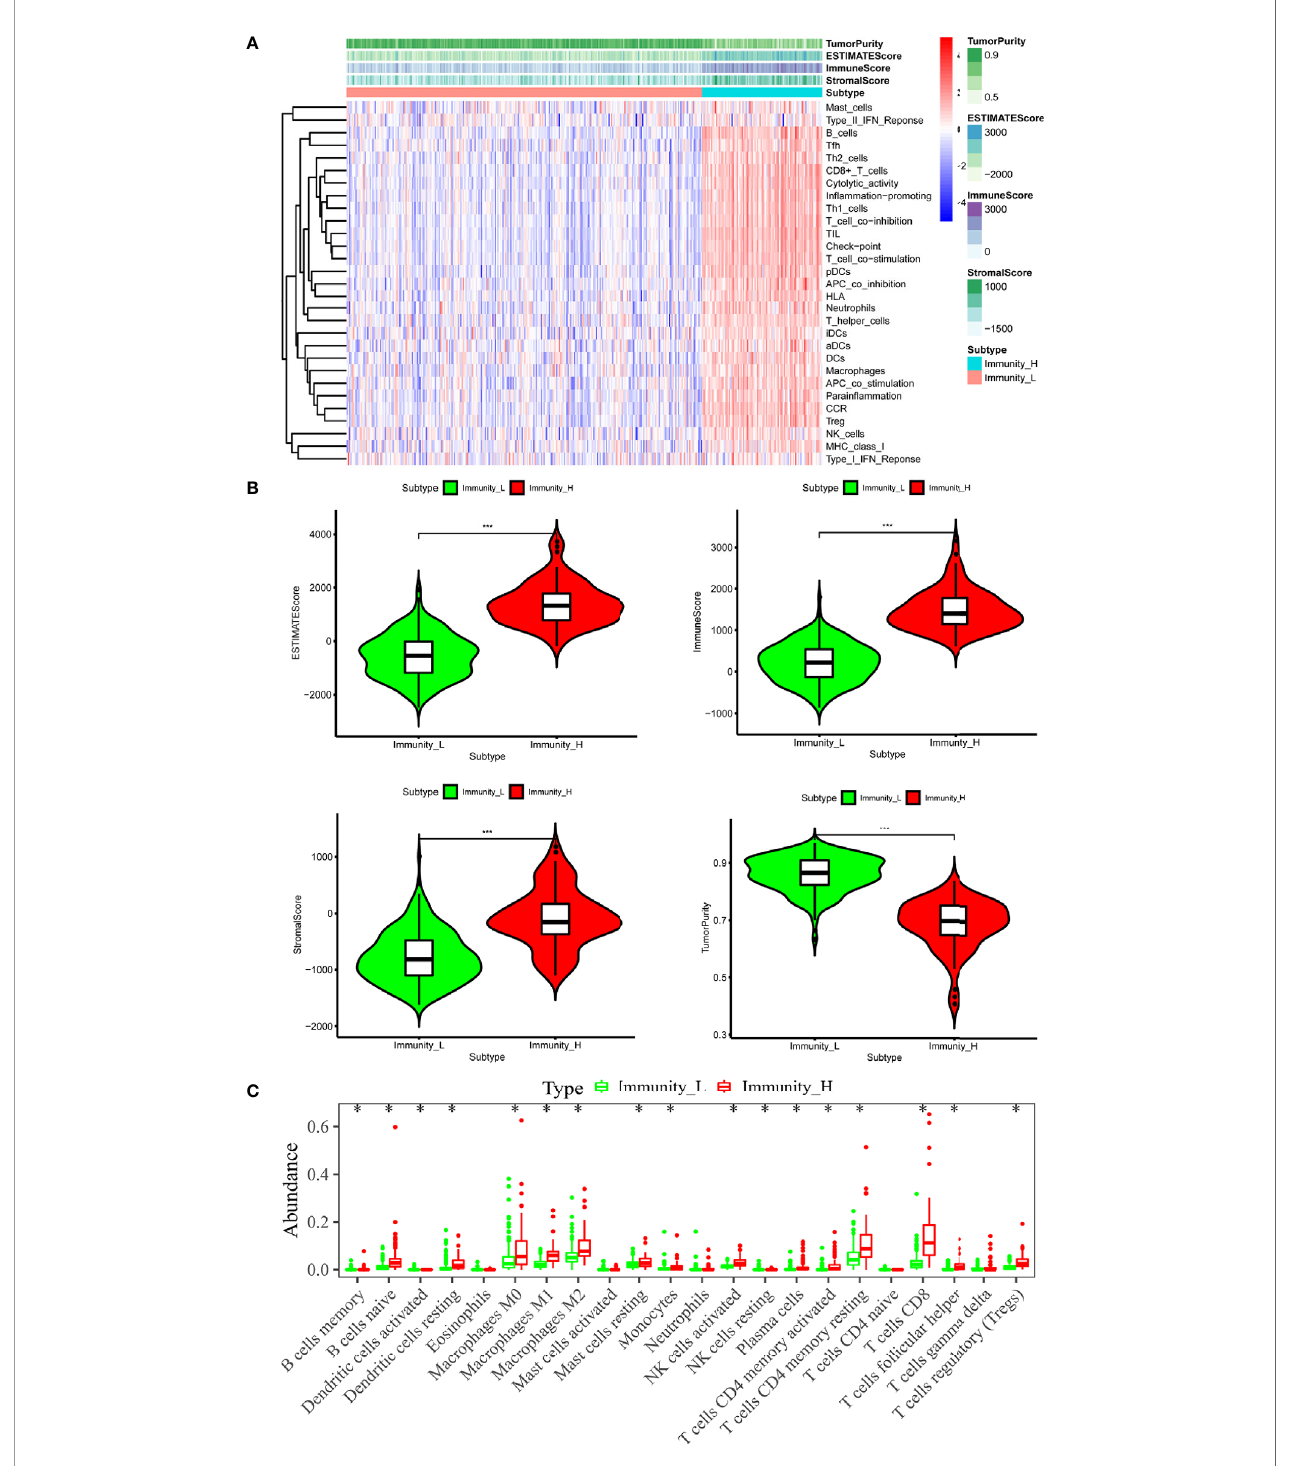
FIGURE 1 | The immune landscape of the TME in HCC. (A) The heatmap showed that the immunity high group had lower Tumor Purity but higher ESTIMATE Score, Immune Score and Stromal Score. The TME of the two groups was signi fi cantly different. (B) The box chart showed that there was a signi fi cant positive correlation between immunity high group and ESTIMATE Score, Immune Score and Stromal Score, respectively, while there was a positive correlation between immunity low group and Tumor Purity. (C) Absolute CIBERSORT algorithm revealed that the abundance levels of immune cells differ in the immunity high group and immunity low group. *p < 0.05, **p < 0.01, ***p <